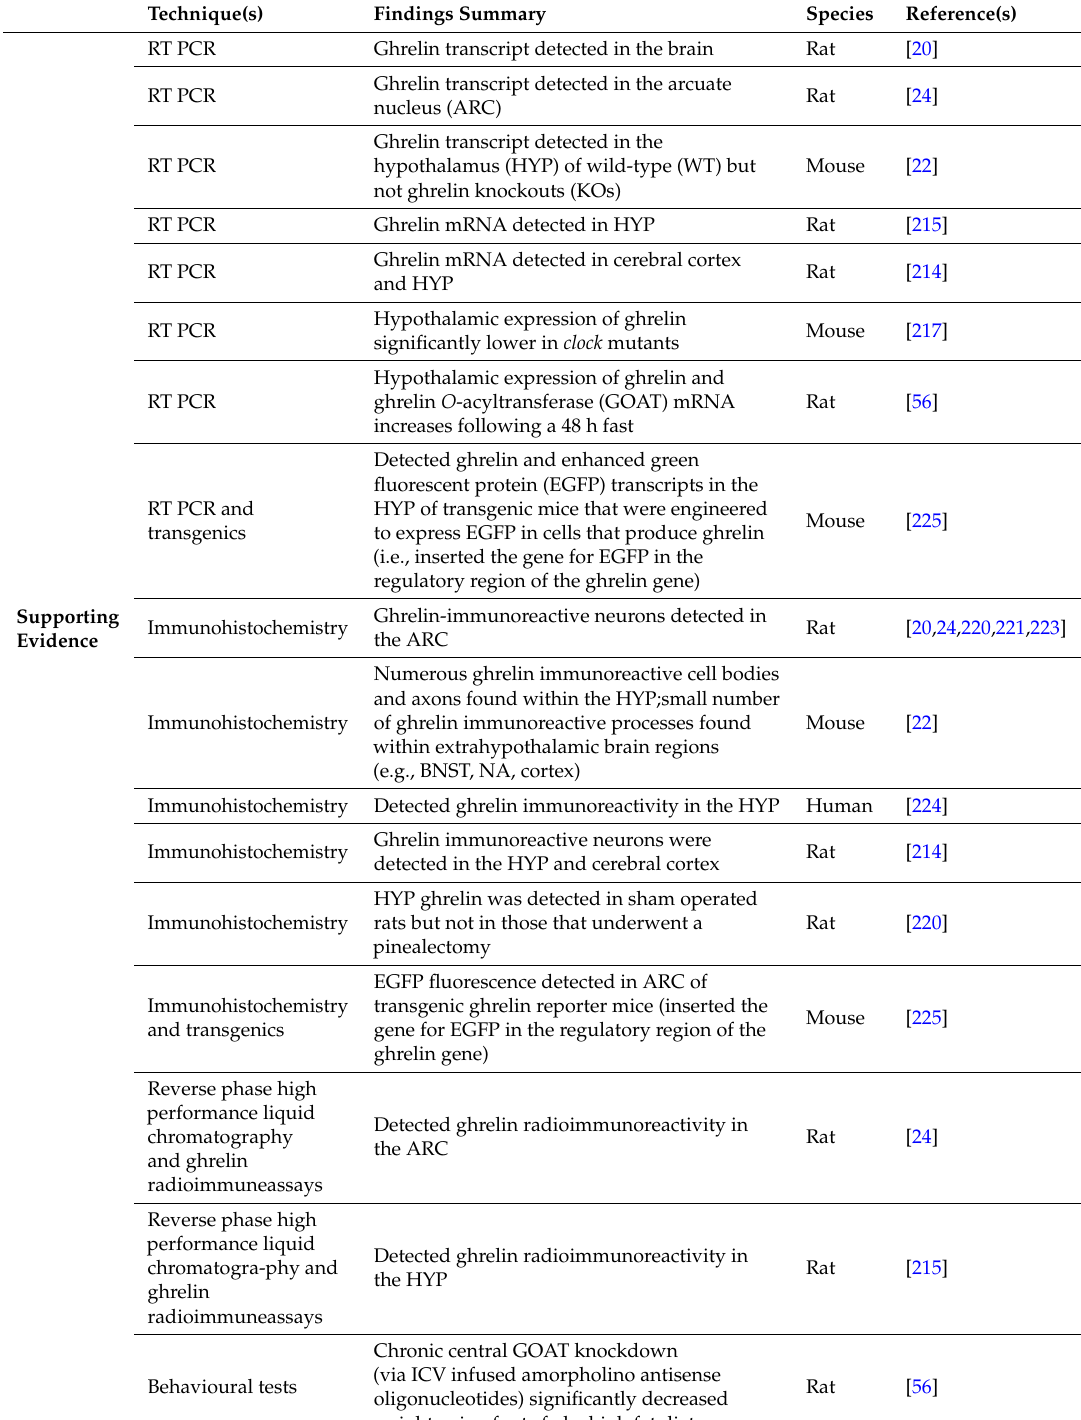
Table 1. Supporting and refuting evidence regarding the central synthesis of